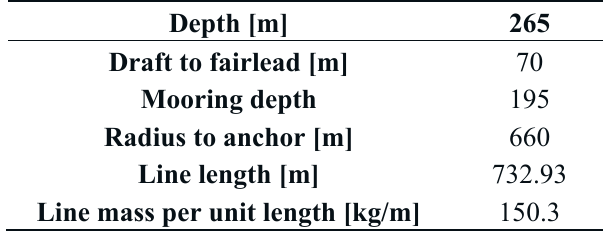
Table 2. Prototype mooring line